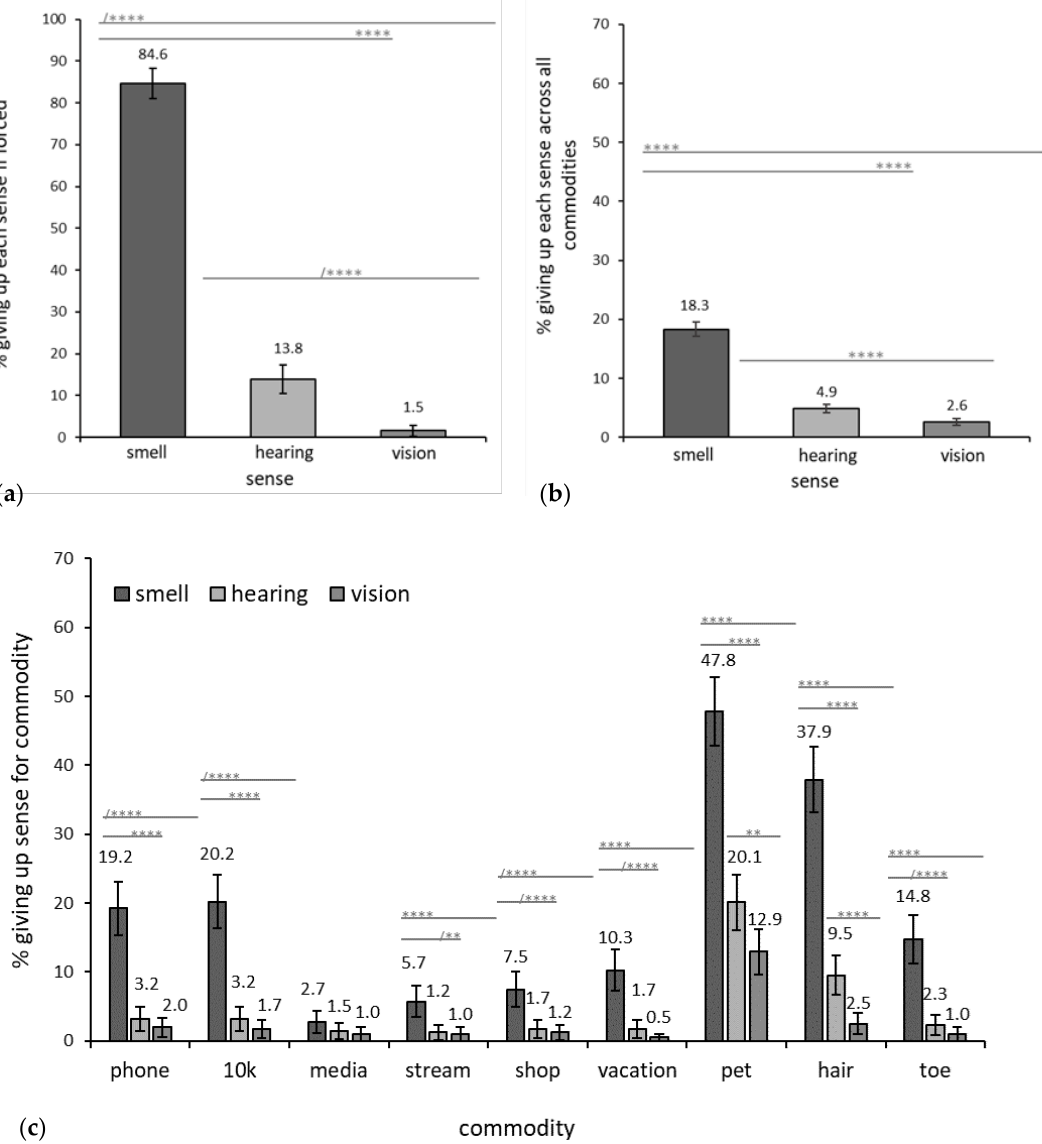
Figure 1. Willingness to give up each sense across all respondents by ( a ) forced choice between the three senses, ( b ) responses by sense collapsed over all commodities, and ( c ) responses by sense and commodity. Note: significance indicated by, ** p < 0.01, **** p < 0.0001; “/” indicates caution on interpretation due to low number of responses of one of the comparators (for details see Methods section).